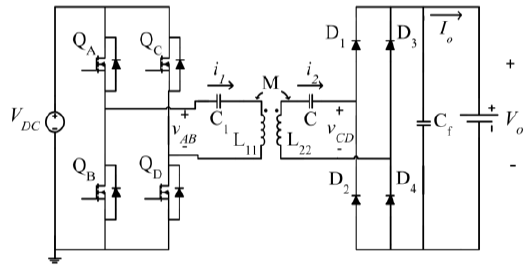
Figure 1. S – S IPTS with passive rectification [13]. Figure 1. S–S IPTS with passive rectification